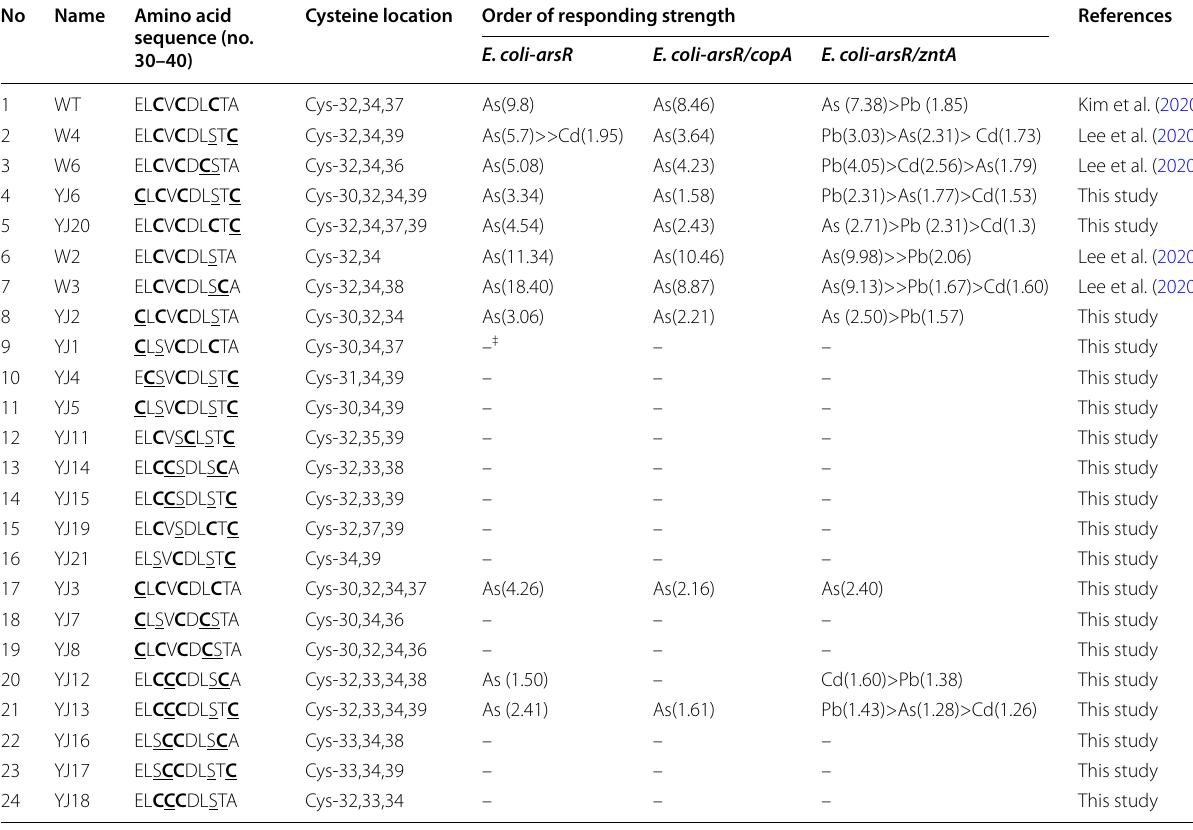
+ Cysteines in amino acid sequences were indicated as bold letters and mutated amino acids were indicated with underlines ‡ Responding strengths toward heavy metal(loid) ions were indicated with induction coefficient values and the values under 1.25 were not